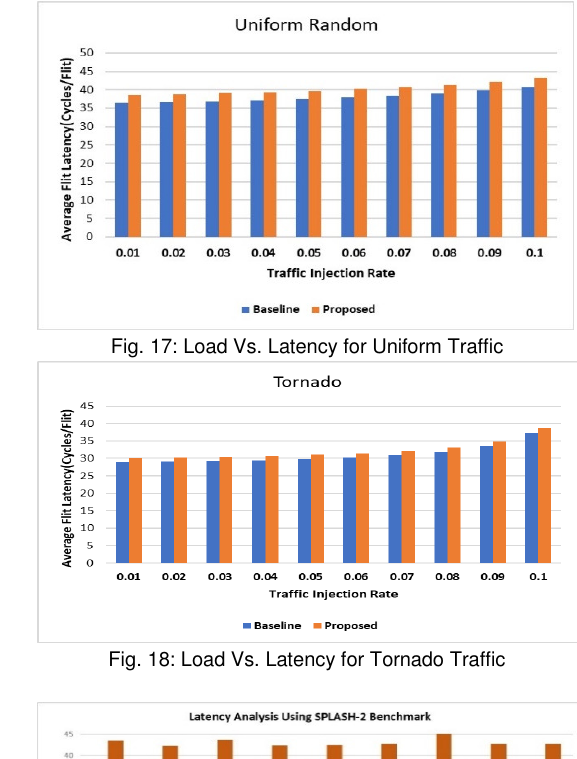
Fig. 18: Load Vs. Latency for Tornado Traffic